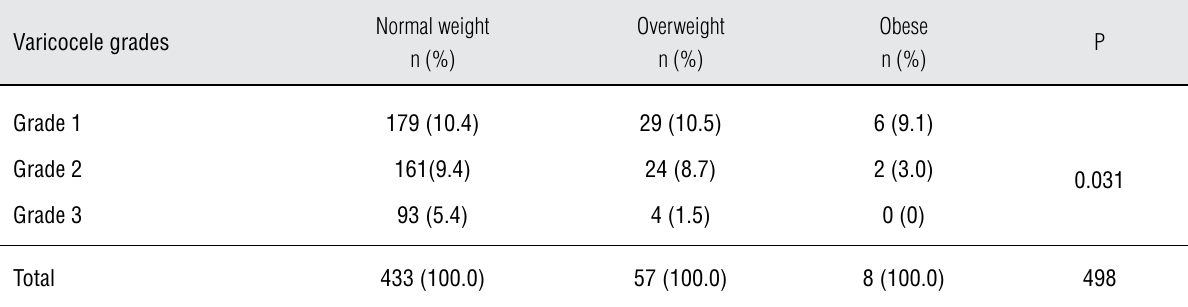
Table 3 - The distribution of varicocele grades according to body mass index. Varicocele